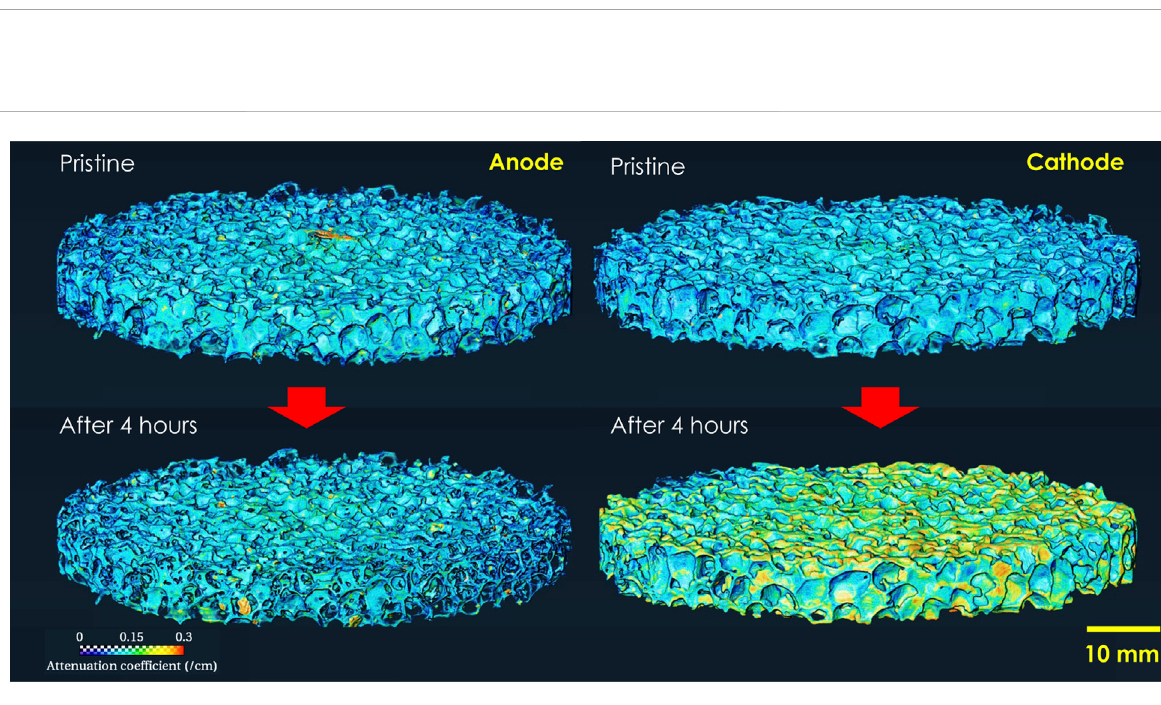
Frontiers in Chemical